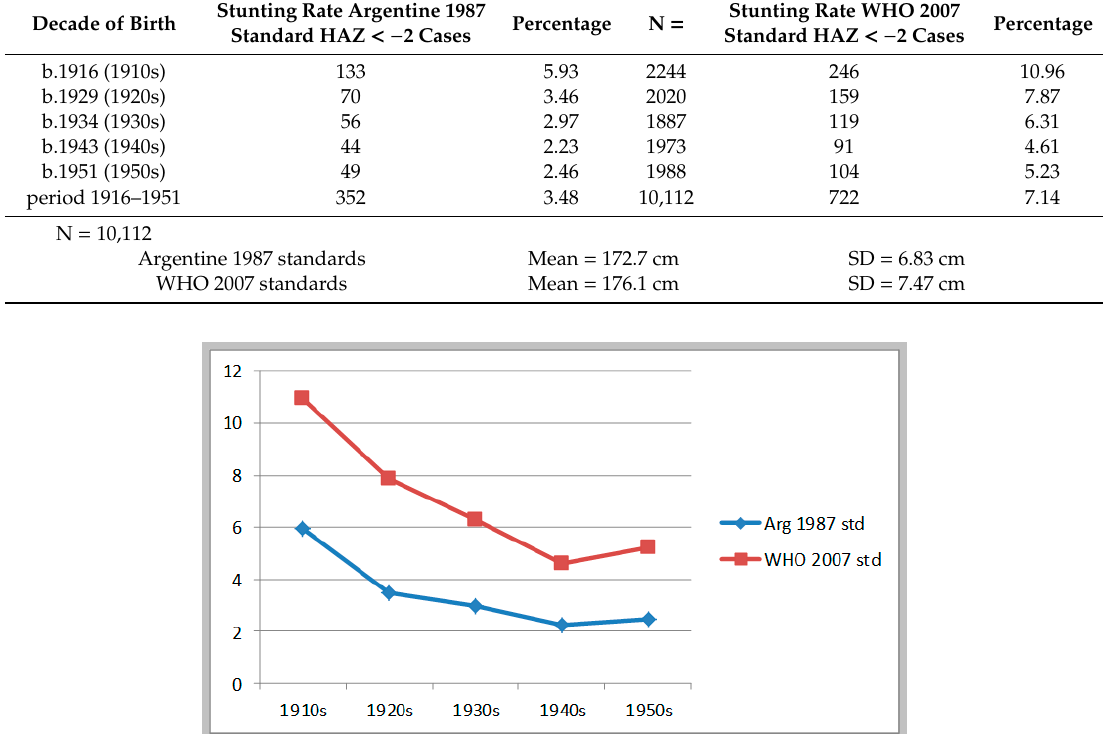
Figure 7. Evolution of malnutrition rates in Argentina (1850s to 1950s). Calculated based on WHO 2007 standards.